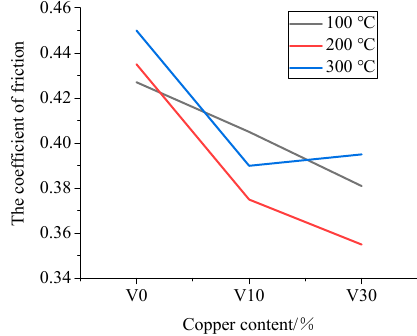
Figure 5. Average friction coefficient measured in the experiment.